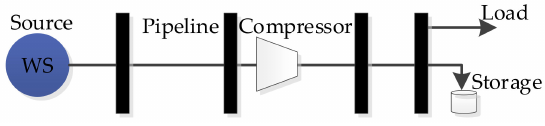
Figure 4. Natural gas